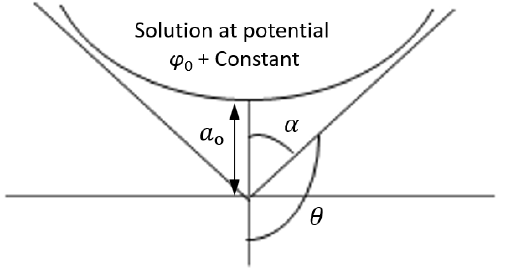
Figure 4. Axisymmetric “infinite” fluid under electrostatic force at a distance a 0 from an equipotential plane.